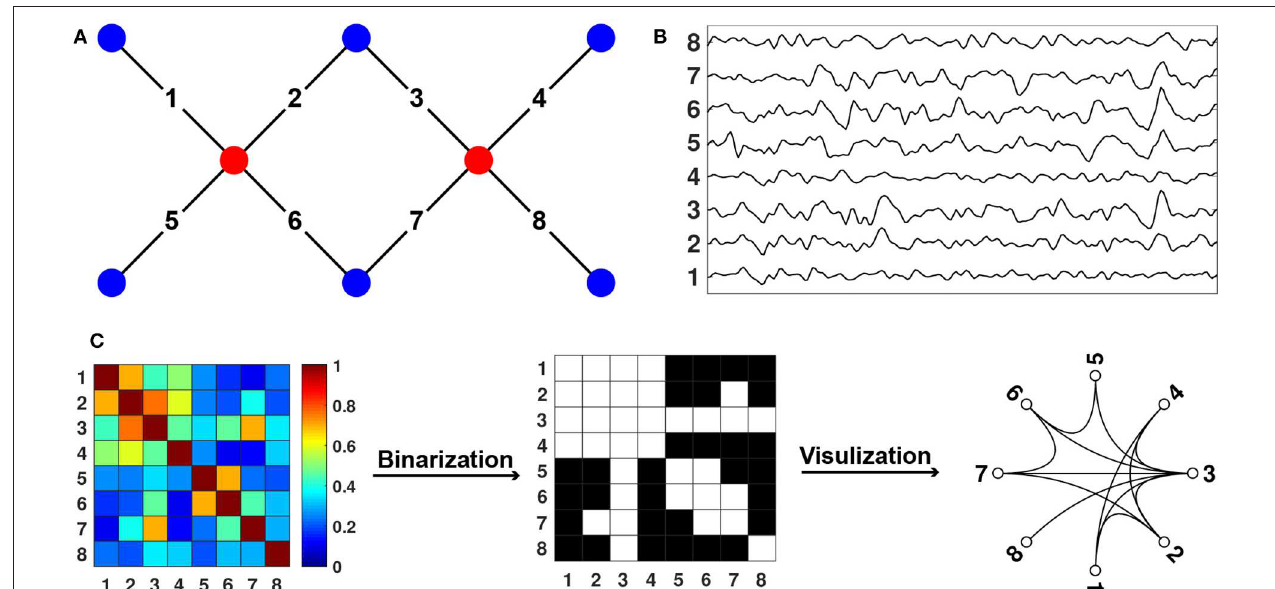
FIGURE 2 | Diagram for fNIRS Data Collection and Processing. (A) Sources, detectors, and channels. The red dots represent the sources, and the blue dots represent the detectors. The solid black lines linking the red and blue dots represent the channels. (B) Changes in hemoglobin concentration signals from